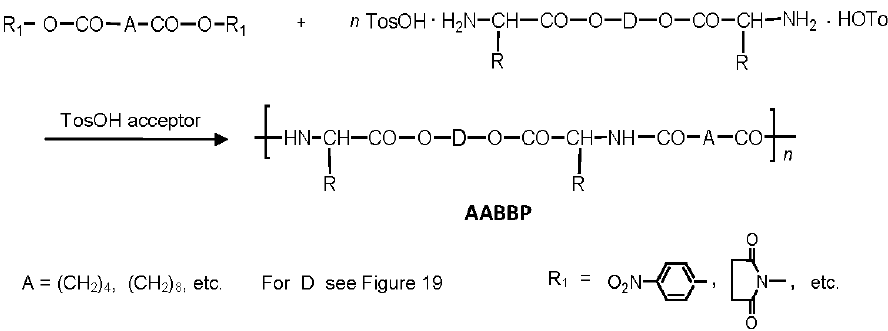
Figure 24. Synthesis of AABBP via active polycondensation.